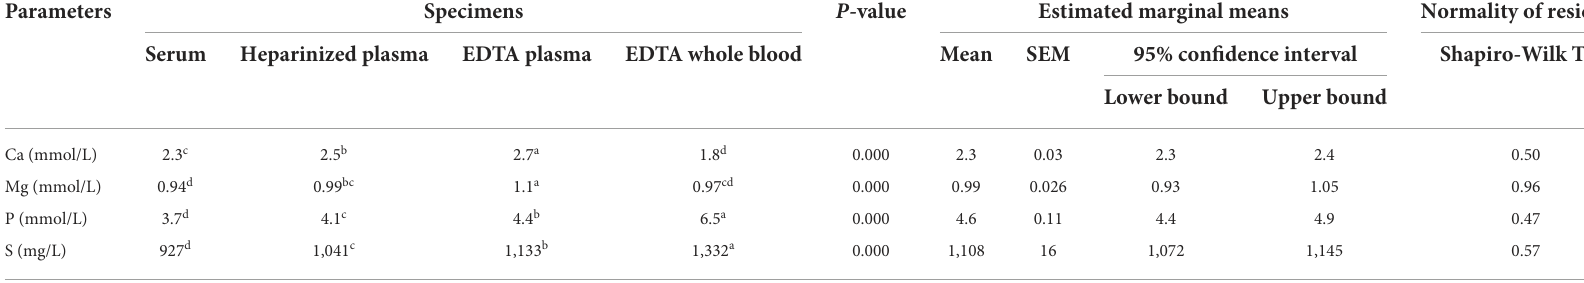
TABLE 4 Linear mixed model analysis of major element concentrations in different blood specimens of dairy cows ( n = 10).